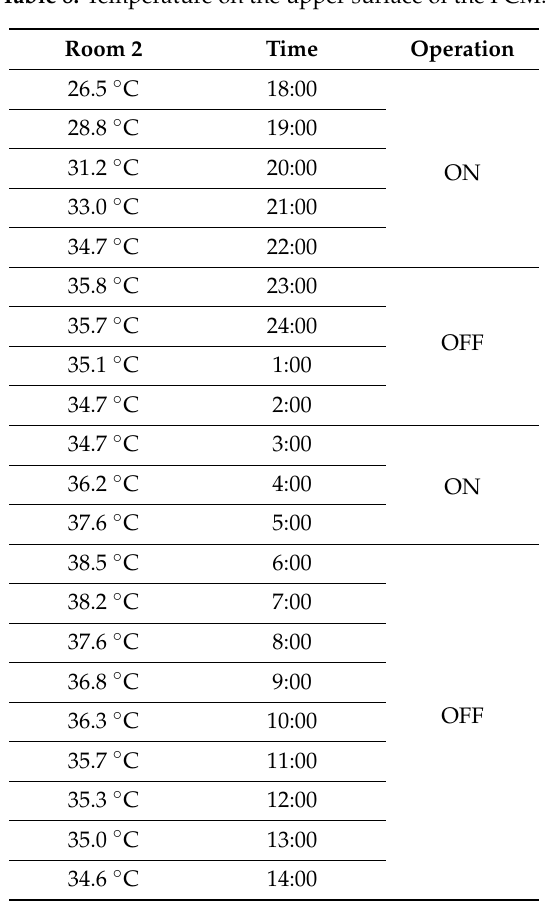
Figure 11. Temperature on the upper surface of the PCM over time.